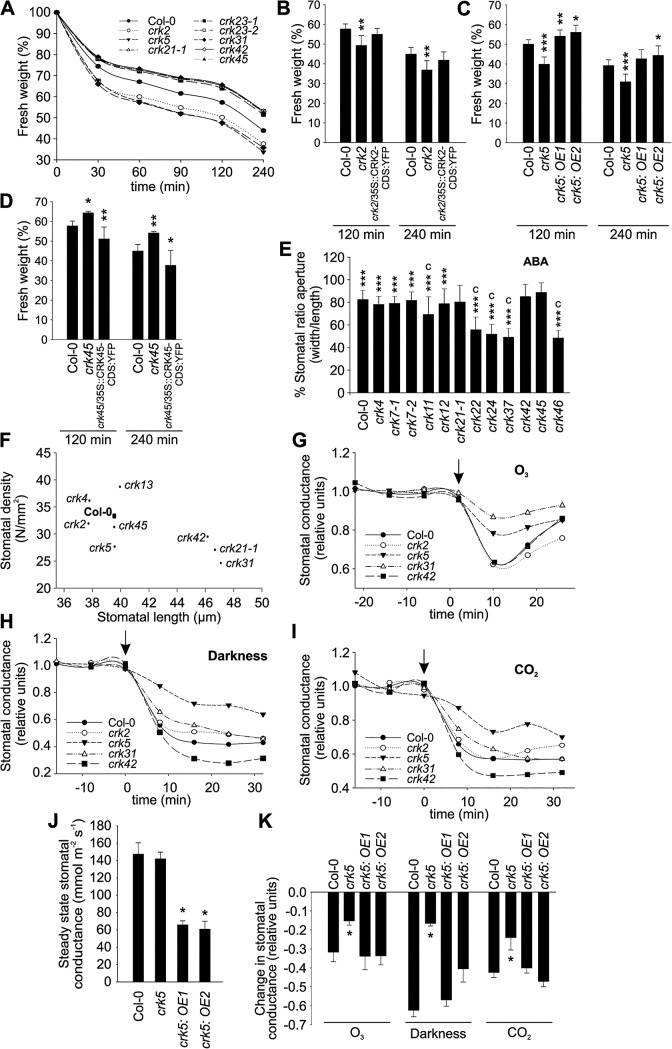
Stomatal development and responses are impaired in specific crks.
(A) A subset of the crk mutants showed altered water loss (shown as decrease of fresh weight) compared to Col-0 wild type plants after detachment of shoots from roots as evaluated from rosette weight. Complementation of the crk2
(B), crk5
(C) or crk45
(D) mutants restored a wild type-like water loss phenotype as interpreted from decrease of fresh weight of excised rosettes. Asterisks indicate differences between crk mutants or complementation lines and Col-0 with statistical significance at *P<0.05, **P<0.01 and ***P<0.001 according to one-way ANOVA with post hoc Tukey HSD. The experiment was repeated three times with similar results. (E) Stomatal apertures were measured 2 h after abscisic acid (ABA) treatment. Some crk mutants are impaired in stomatal closure 2 h after treatment with 10 μM ABA. Results are means of % stomatal aperture ratio (width/length) ± SE (average number of stomata measured = 250). Asterisks indicate statistical significance between control and ABA treatment at *P<0.05, **P<0.01 and ***P<0.001 (linear model, single-step p-value adjustment). Lowercase letters indicate statistical significance between wild type Col-0 and crk mutant at P<0.05 (a), P<0.01 (b) and P<0.001 (c) according to one-way ANOVA with post hoc Dunnett’s test. (F) Stomatal density (number of stomata/mm2) is correlated with stomatal length (μm). Most of the crks exhibit a smaller stomata density which correlates with longer stomata (Pearson correlation -0.69, p-value = 0.04). Results are means (average number of stomata measured = 500). (G-I) Time courses of stomatal conductance (relative units) in response to a 3 min pulse of 500–600 ppb of O3 (G), darkness (H) and elevation of CO2 from 400 ppm to 800 ppm (I) in a subset of crk mutants and Col-0. Stimuli were applied at 0 time point, which is indicated by an arrow; pre-treatment stomatal conductance was used for normalization. Graph shows the mean of two experiments (n = 6). (J) Overexpression of CRK5 led to lower stomatal conductance compared to Col-0 wild type. (K) Complementation of the crk5 mutant restored wild type-like phenotype in the response to a 3-min pulse of 500–600 ppb of O3, darkness, and elevating CO2 from 400 to 800 ppm. Asterisks indicate differences between crk mutants or complementation lines and Col-0 with statistical significance at *P<0.05 according to one-way ANOVA with post hoc Tukey HSD. The experiment was repeated three times with similar results.